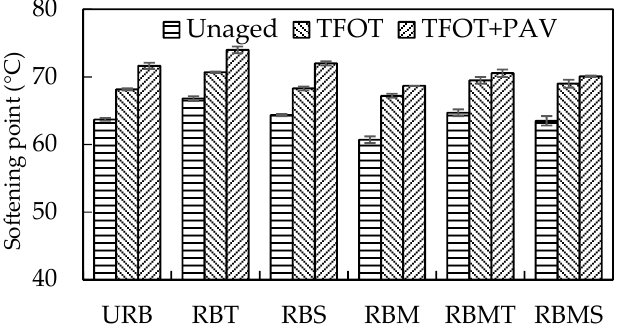
Figure 3. E ff ect of modification methods on the softening point of rubberized bitumen. Figure 3. Effect of modification methods on the softening point of rubberized bitumen.